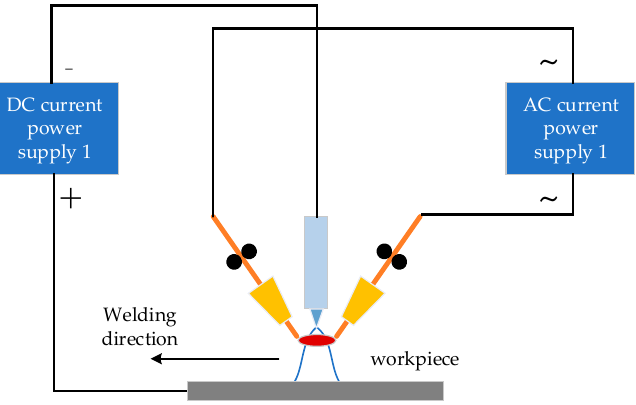
Figure 5. Cross-coupling arc welding process.